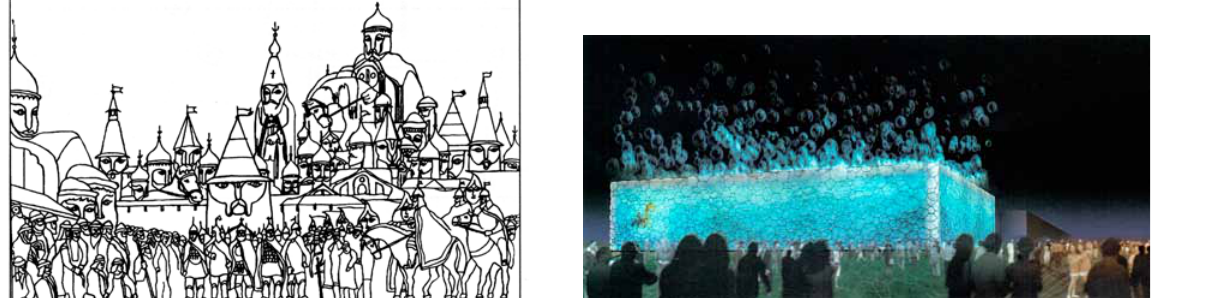
fig. 11. Panoramic view of the city center of Pskov from the old market side, image-based “reading”. © alexander Barabanov. (Barabanov 2002).